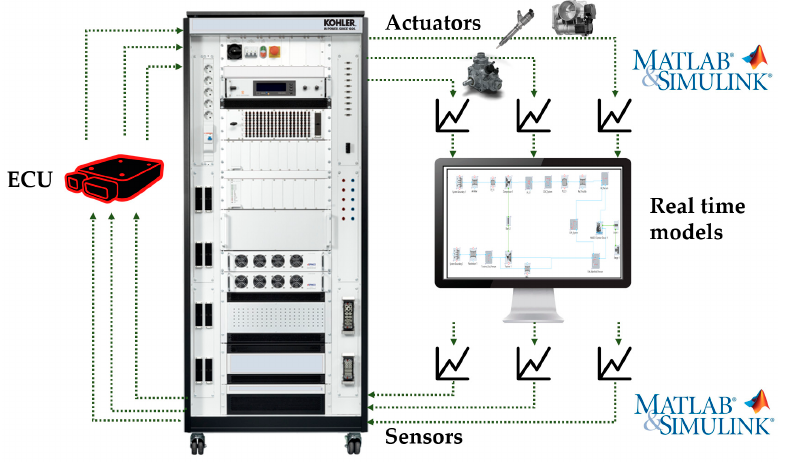
Figure 2. Hardware in the Loop Simulator.